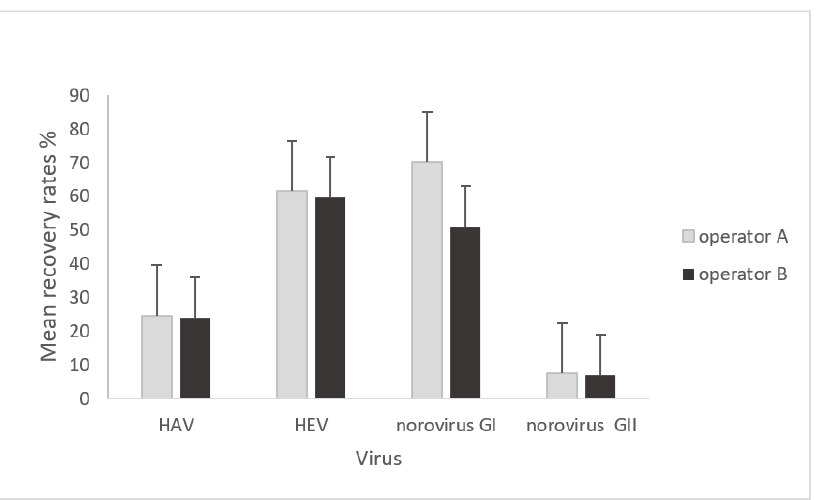
Figure 2. Comparison of mean recovery rates of HAV, HEV, norovirus GI, and norovirus GII according to the operator factor (operator A and operator B). For each virus, 8 analyses were performed by each operator (4 foodstuffs for all settings with all levels of inoculation) and pure RNA extracts were analyzed in duplicate with the RT-qPCR assay. Results are expressed as mean recovery rates (%) ± standard deviation (SD). one-way ANOVA; p = 0.0826. For operator A, the means of recovery rates for all settings were 24.64%, 61.49%, 70.25%, and 7.67% for HAV, HEV, norovirus GI, and norovirus GII, respectively. For operator B, the means of recovery rates were 24.00%, 59.59%, 50.91%, and 6.95% for HAV, HEV,